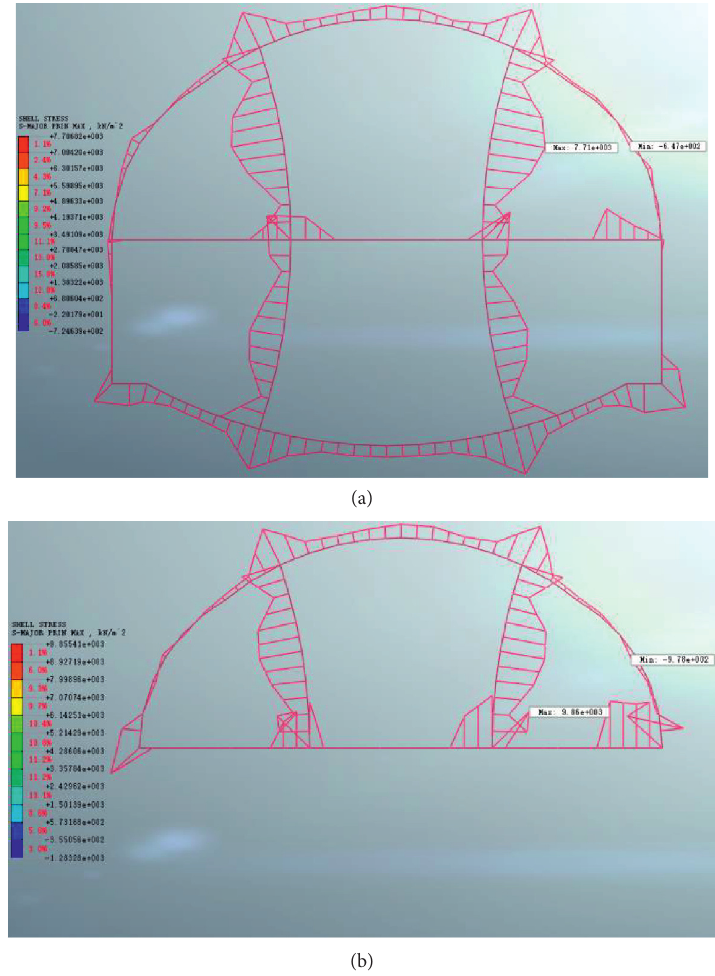
Figure 13: Overall stress diagram of the tunnel support structure. (a) Overall stress diagram of the tunnel support structure in scheme I. (b) Overall stress diagram of the tunnel support structure in scheme